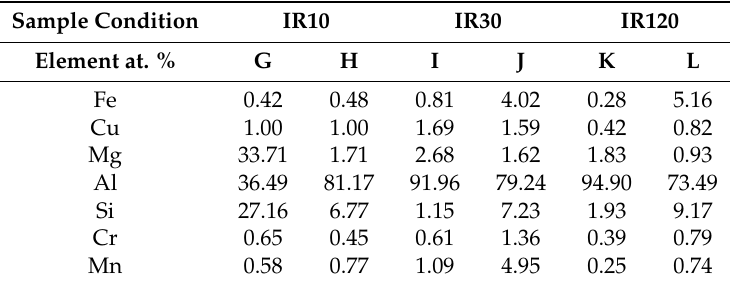
Table 4. EDS analysis results for IR-heated specimens.